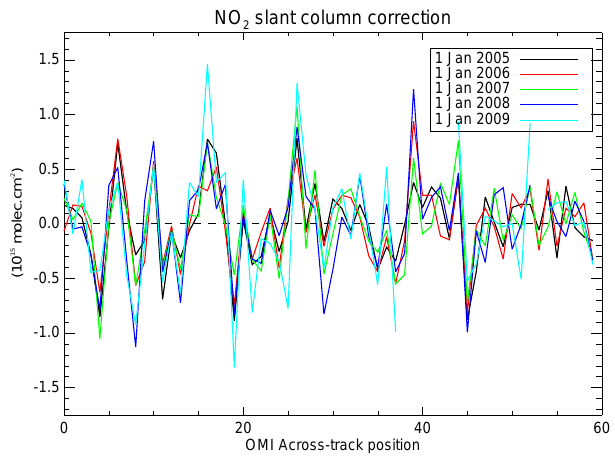
Fig. 8. OMI NO 2 slant column destriping corrections computed for 1 January 2005-2009. The corrections represent the daily averages of 14 consecutive orbital